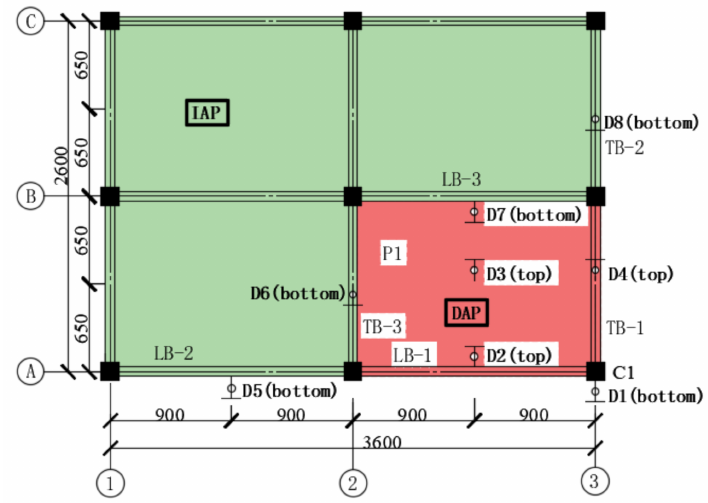
Figure 8. Definition of DAP and IAP; red color is indicative of DAP, and green represents IAP. In order to explore the deformation of the frame beams of DAP with respect to the response of progressive collapse after corner column loss, vertical displacements in the middle span of beam LB-1 (D2), TB-1 (D4) and slab P1 (D3) were measured by using vertically arranged displacement transducers. The vertical displacements of the LB-1, TB-1 and P1 along with applied vertical displacement are demonstrated in Figure 9 , where negative values represent downward movement; in contrast, positive values are indicative of upward movement. It is observed that the components exhibited quintessential elastic deformations under small displacements. With increasing displacements of the sectioned column, movements developed in DAP members were not strictly linear, which implies that the plastic hinges were basically formed in the joint region. From Figure 9, it can be observed that the increased rate of vertical displacement at D2 obviously exceeded the one at D4; the value of D2 reached 56 mm (0.44 D1), while D4 approached 40 mm (0.32 D1)